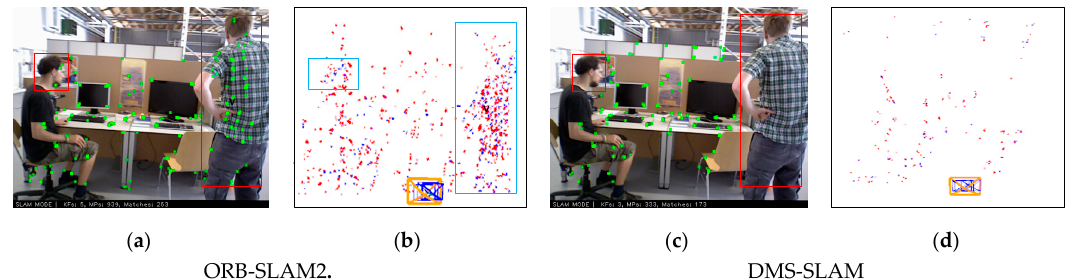
Figure 7. ( a , c ) System initialization results of ORB-SLAM2 and DMS-SLAM on the fr3_walking_xyz dataset of TUM, and the red boxes indicate the area that is moving. ( b , d ) The local map is built after system initialization, and the blue boxes represent the dynamic 3D points in the local map.